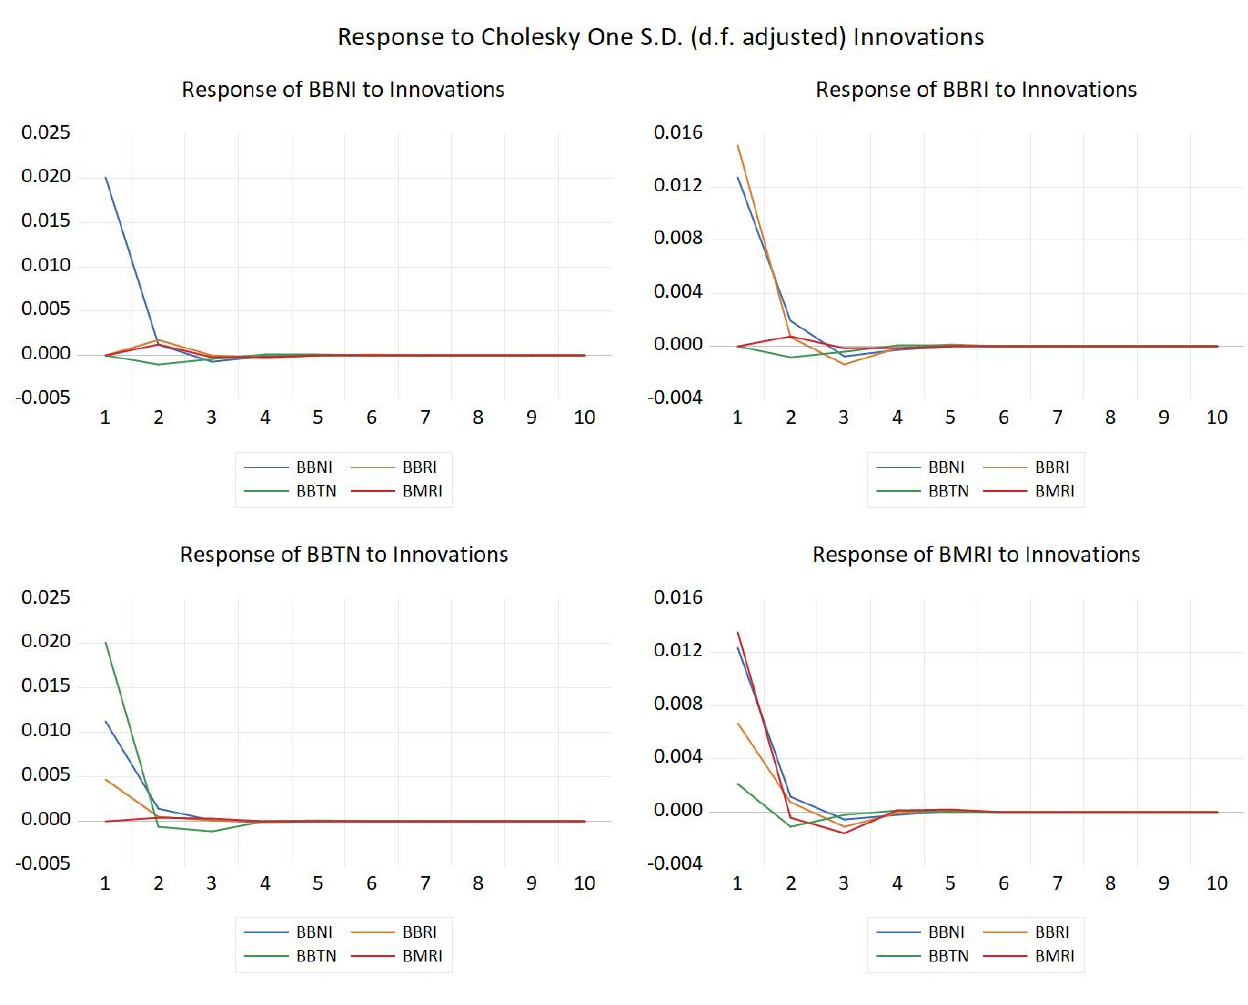
Figure 4. Combined graphs for IRFs.